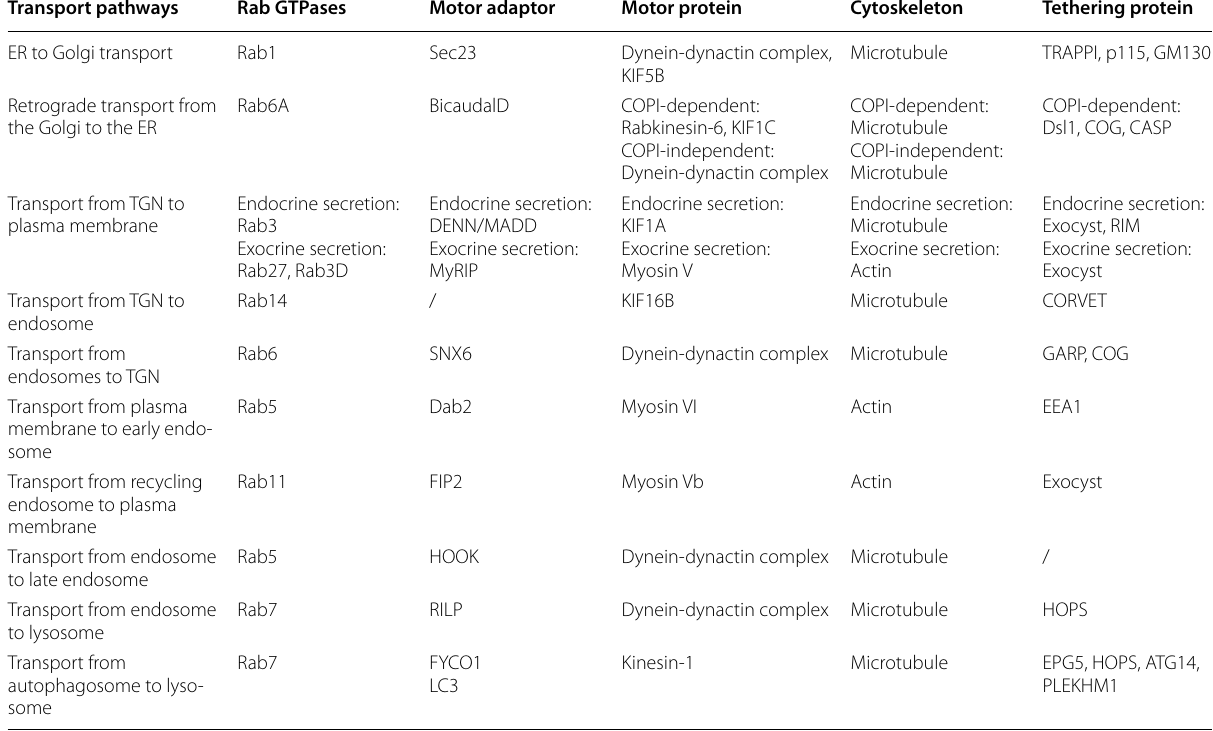
Table 2 Classic proteins involve in different vesicle transport pathways Transport pathways Rab